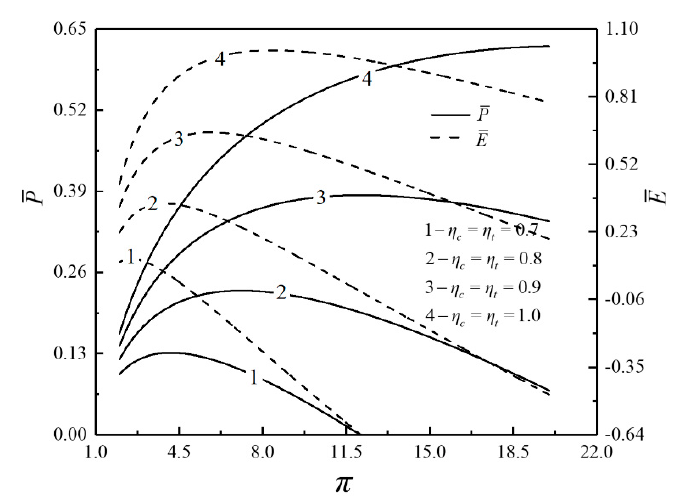
Figure 7. Relationships of P and E versus π with di ff erent η c and η t .